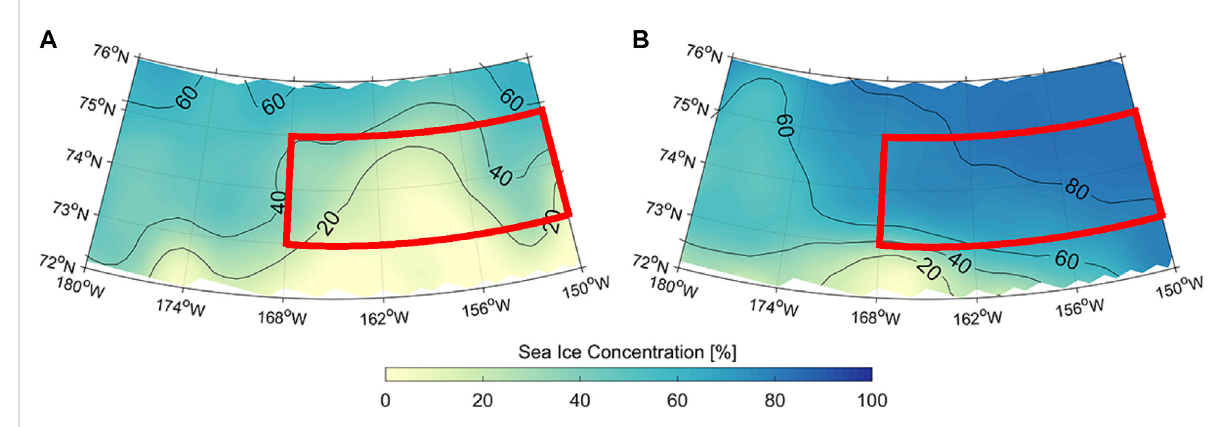
FIGURE 1 SIC in July for 2019 (A) and 2020 (B) . Red polygons encapsulate areas represents the study area of this